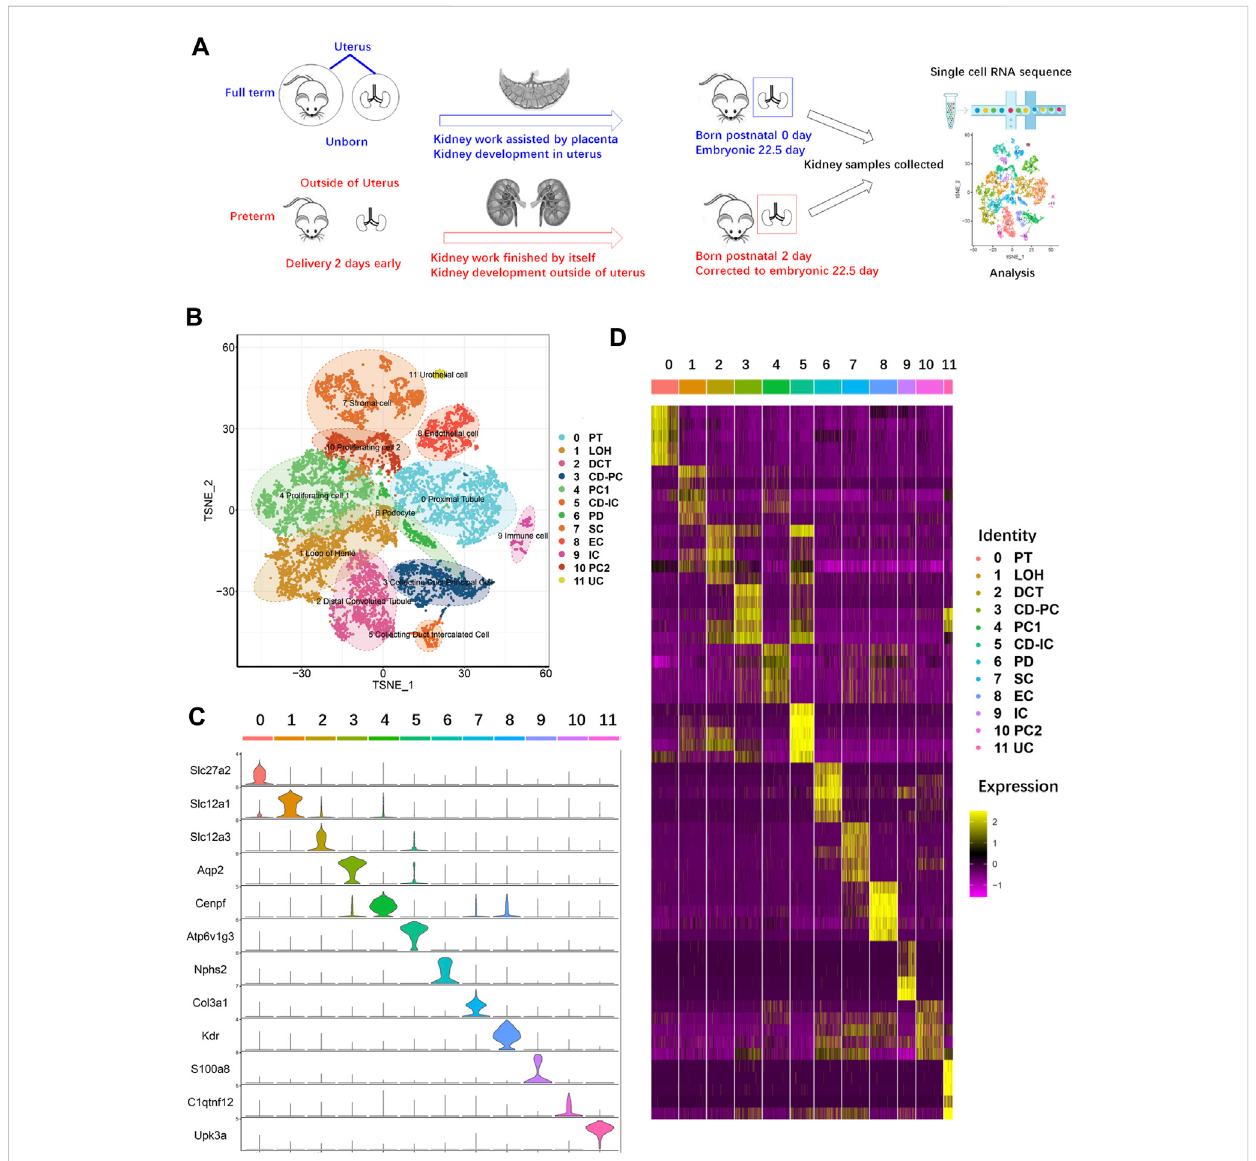
FIGURE 2 Single-cell RNA sequencing of kidney cells from age-matched preterm (postnatal day 2) and full-term rats (postnatal day 0). (A) Overview of the study design and experimental procedure. (B) Full-term and preterm rat kidneys were collected at birth and 2 days postnatally, respectively. After single- cell suspensions were generated, sequencing and analysiswereperformed. A totalof 13815 cells and 20 original clusters wereidenti fi ed. After analysis of differentially expressed genes in the 20 original clusters with known gene markers, 12 different cell types were identi fi ed and annotated on the right side of the TSNE results. (C) Violin plots showing the expression levels of representative marker genes across the 12 clusters. The vertical axis shows the gene expression value. Each color represents one cluster, as indicated on the right side in (D) . The annotations of each color are presented on the right side of (D) . (D) Heatmap of the gene expression patterns of the top ten cluster-speci fi c genes in 12 clusters. Different clusters are identi fi ed by different colors, as indicated at the top of the heatmap and annotated on the right side of the heatmap. The color bar ranging from yellow to red – purple re fl ects the relative expression levels from high to